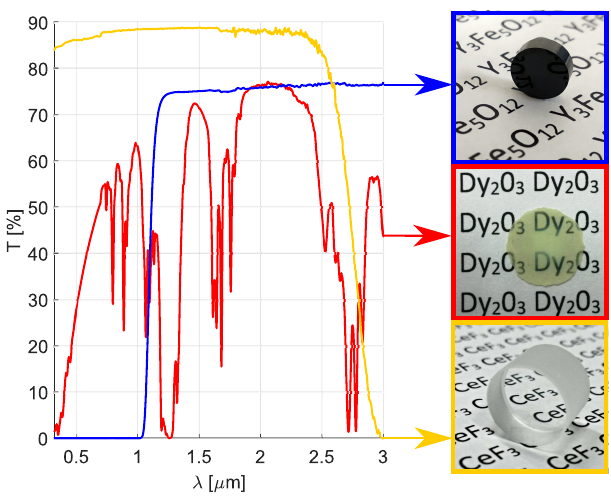
Figure 1. In-line optical transmittance of the investigated